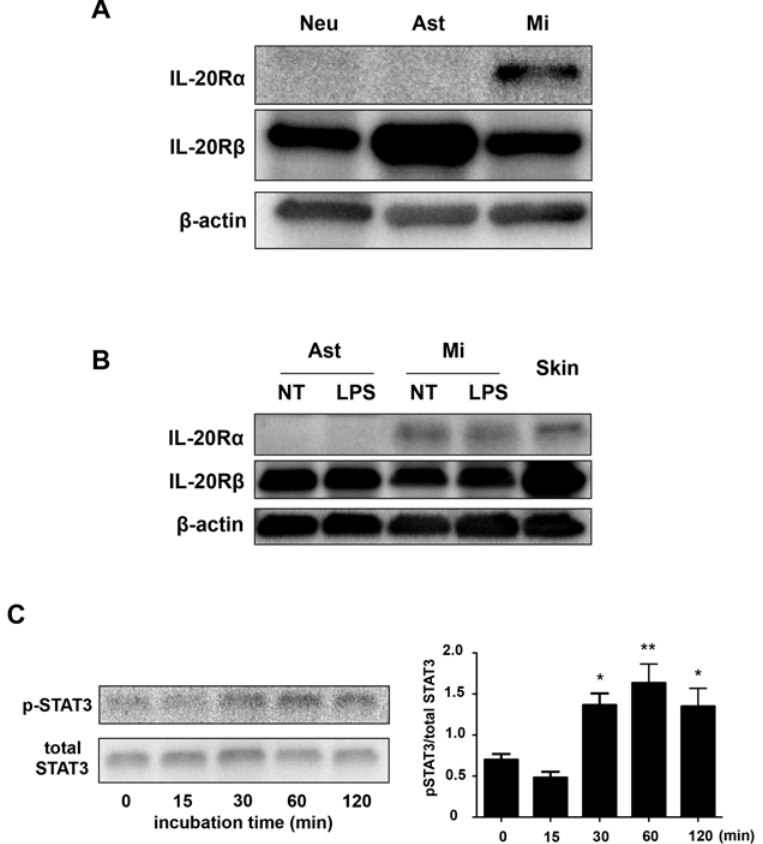
Fig 2. Microglia are the only cells in the CNS that express functional IL-19 receptor. (A) Western blotting data for receptors of IL-19. Only microglia express both the IL-20R α and IL-20R β subunits. Neu, neurons; Ast, astrocytes; Mi, microglia. (B) Western blotting data for receptors of IL-19. LPS stimulation did not change the expression levels of IL-19 receptor subunits. Skin was used as the positive control. NT, untreated; LPS, LPS-treated. (C) Western-blotting analysis of STAT3 phosphorylation in microglia treated with 100 ng/ml IL- 19. IL-19 induced STAT3 phosphorylation, the main downstream signal of the IL-19 receptor. All quantitative data are expressed as means ± SD (n = 3). * , p < 0.01 vs . 0 min. ** , p < 0.001 vs . 0 min.